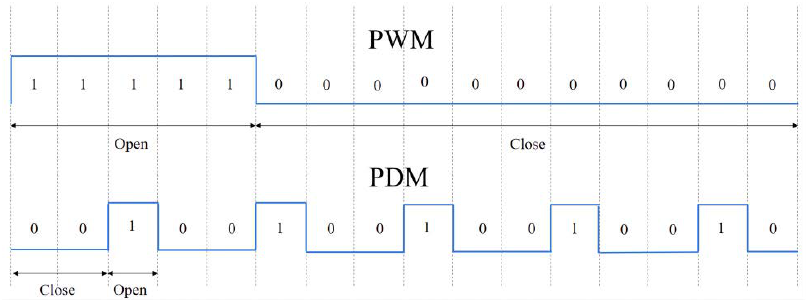
Figure 5. Comparison of PDM and PWM waveforms in a cycle.